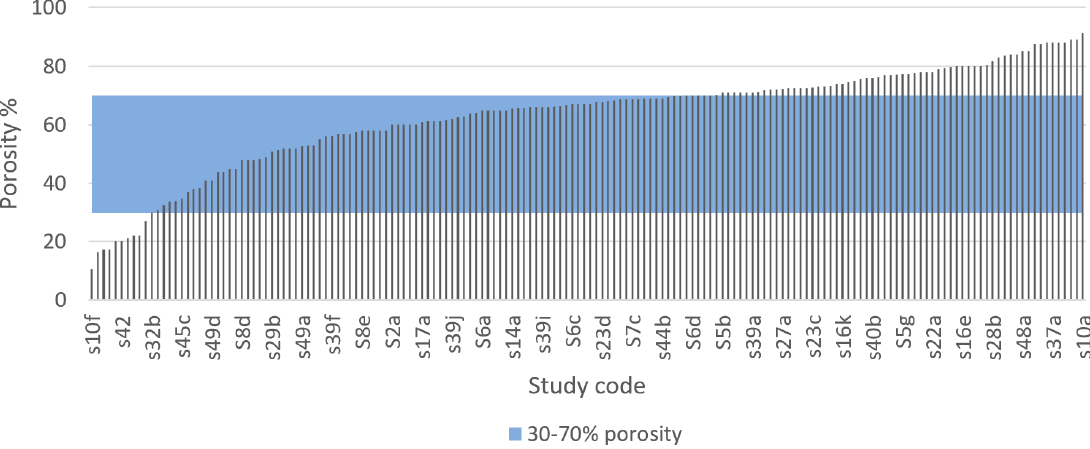
Figure 9. Porosity of implant specimens in the reviewed articles, compared with the Ideal Quality Attribute (IQA) target zone.